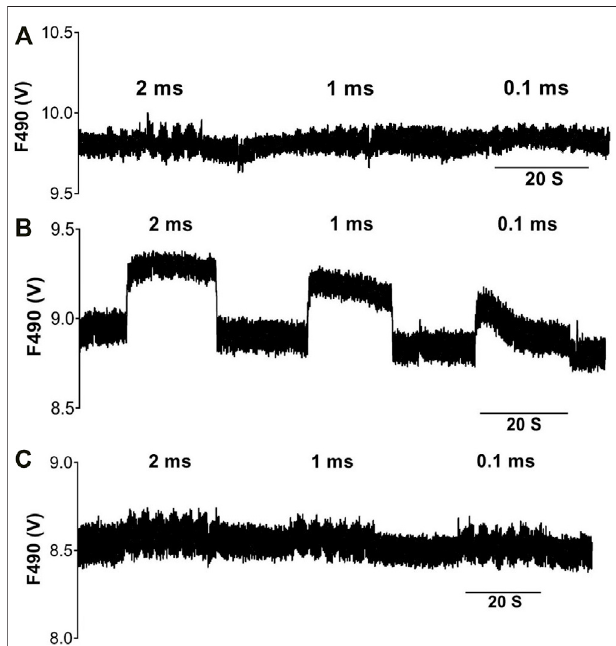
FIGURE 2 | Voltage and frequency dependent changes in NO fl uorescence during VNS. Raw data illustrating DAF-2 fl uorescence at a 490 nm(F490)excitationwavelengthduringhighvoltage-lowfrequency(3 Hz) stimulation (A) , low voltage-high frequency (20 Hz) stimulation (B) and low voltage-low frequency (3 Hz) stimulation (C) , at varying pulse